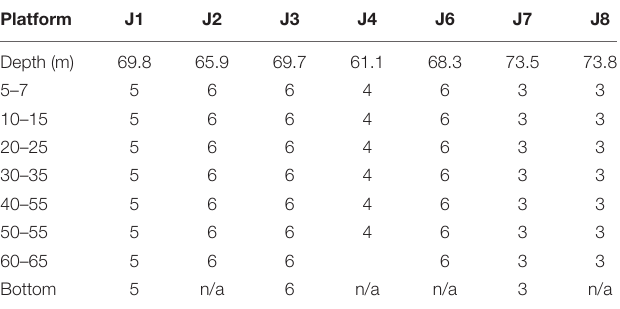
TABLE 2 | The number of 160.2 m 3 samples from each of the platforms.